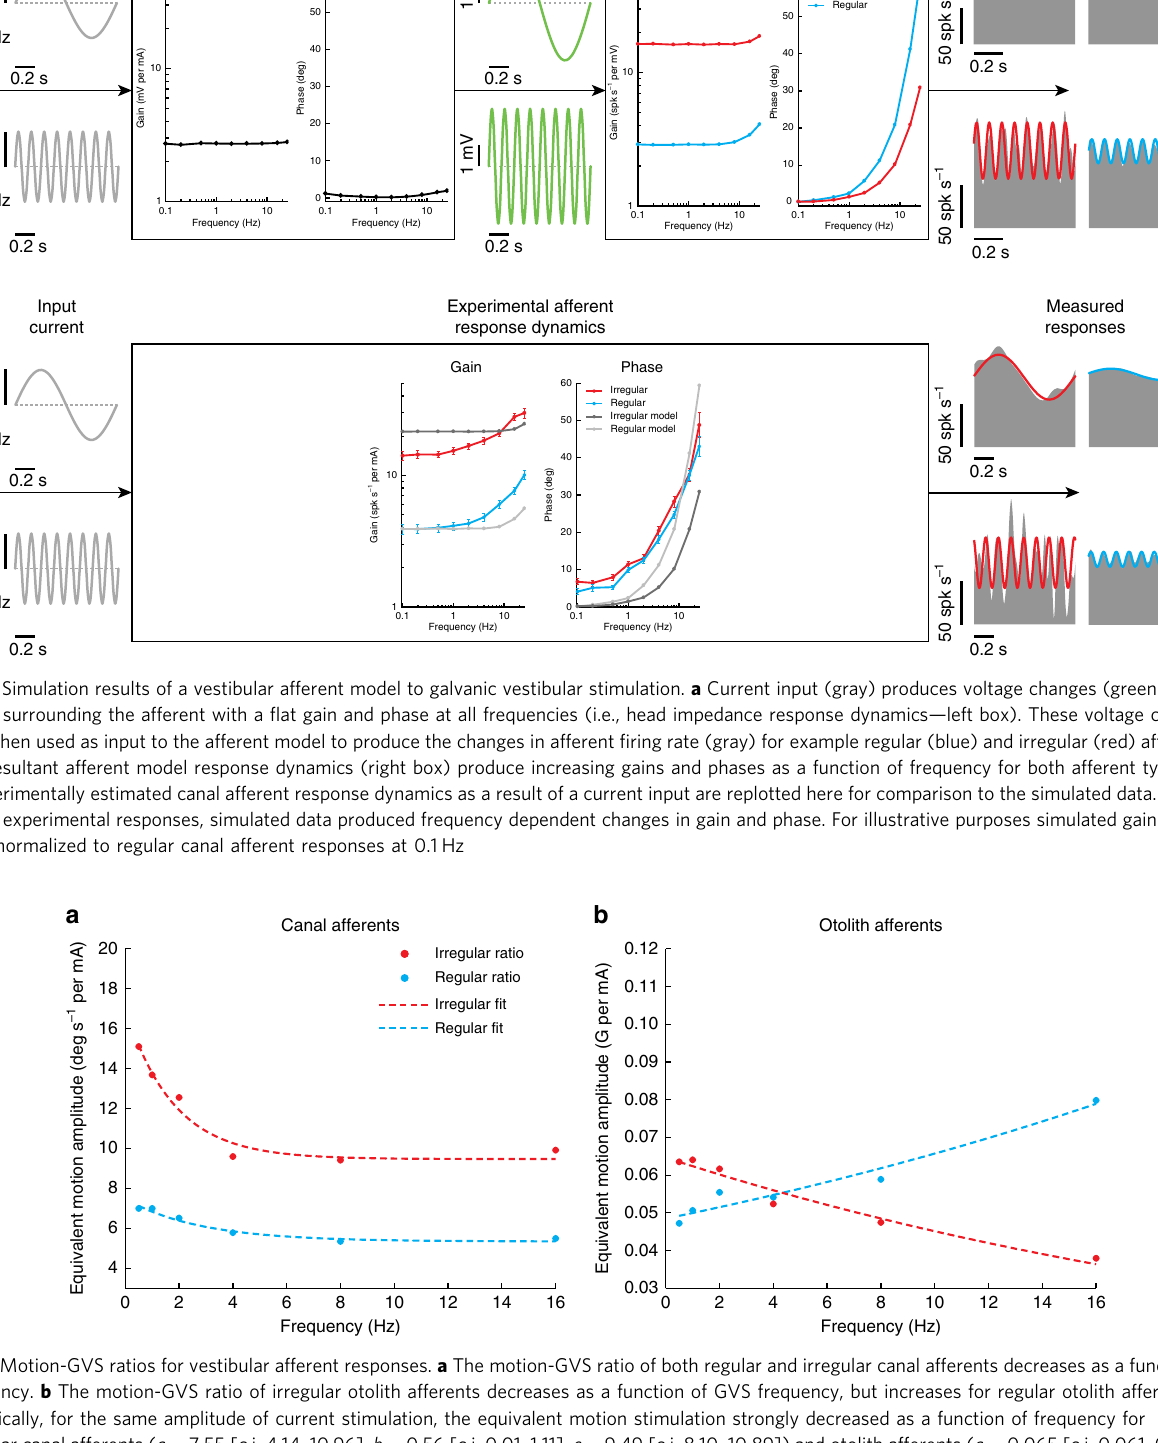
Fig. 7 Motion-GVS ratios for vestibular afferent responses. a The motion-GVS ratio of both regular and irregular canal afferents decreases as a function of frequency. b The motion-GVS ratio of irregular otolith afferents decreases as a function of GVS frequency, but increases for regular otolith afferents. Speci fi cally, for the same amplitude of current stimulation, the equivalent motion stimulation strongly decreased as a function of frequency for irregular canal afferents ( a = 7.55 [c.i. 4.14, 10.96], b = 0.56 [c.i. 0.01, 1.11], c = 9.49 [c.i. 8.10, 10.89]) and otolith afferents ( a = 0.065 [c.i. 0.061, 0.069], b = 0.036 [c.i. 0.025 0.047]). In contrast, this ratio was relatively constant for regular canal afferents ( a = 2.13 [c.i. 1.35, 2.92], b = 0.36 [c.i. 0.01 0.71], c = 5.36 [c.i. 4.85, 5.88]), and actually increased as a function of GVS frequency for regular otolith afferents (blue curve, Fig. 6b; a = 0.048 [c.i. 0.044, 0.052], b = − 0.030 [c.i. − 0.039, − 0.022]). For irregular and regular otolith afferents the c parameter was removed from the fi t since con fi dence intervals (c.i.) overlapped zero. All model R 2 > 0.94 –